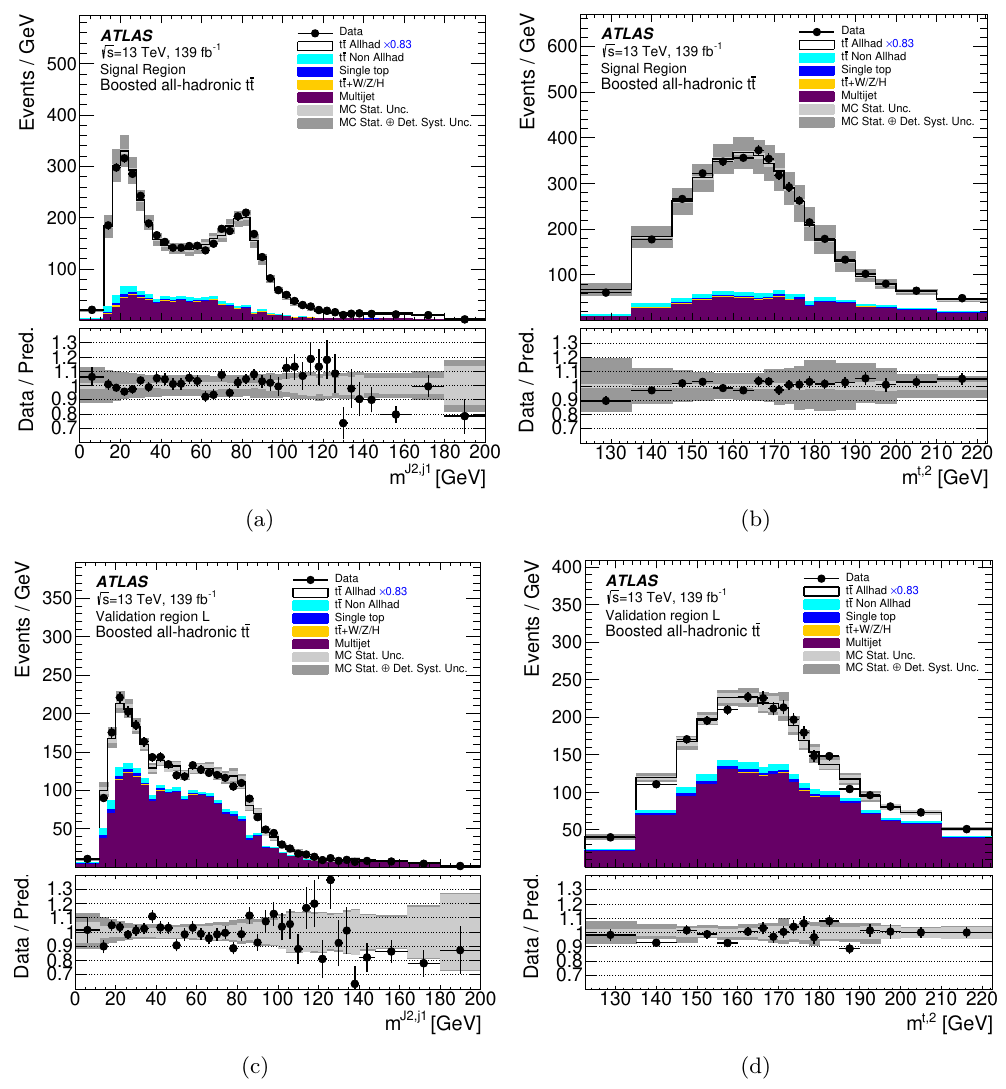
Figure 2 . Kinematic distributions of the second-leading top-quark-candidate jets in the signal region and validation region L. The mass distributions of the leading R = 0 . 4 anti- k t jet in the second-leading large- R jet for events in the signal region and region L are shown in (a) and (c), respectively. The second-leading large- R jet-mass distributions for the events in the signal region and validation region L are shown in (b) and (d), respectively. The signal prediction (open his- togram) is based on the Powheg + Pythia 8 t ¯ t calculation normalized to the observed yield in the signal region. The background (solid histogram) is the sum of the data-driven multijet estimate and the MC-based expectation for the contributions of non-all-hadronic t ¯ t , single-top-quark, and t ¯ t + W/Z/H processes. The light grey bands indicate the statistical uncertainties and the dark grey bands indicate the combined statistical and detector-related systematic uncertainties defined in section